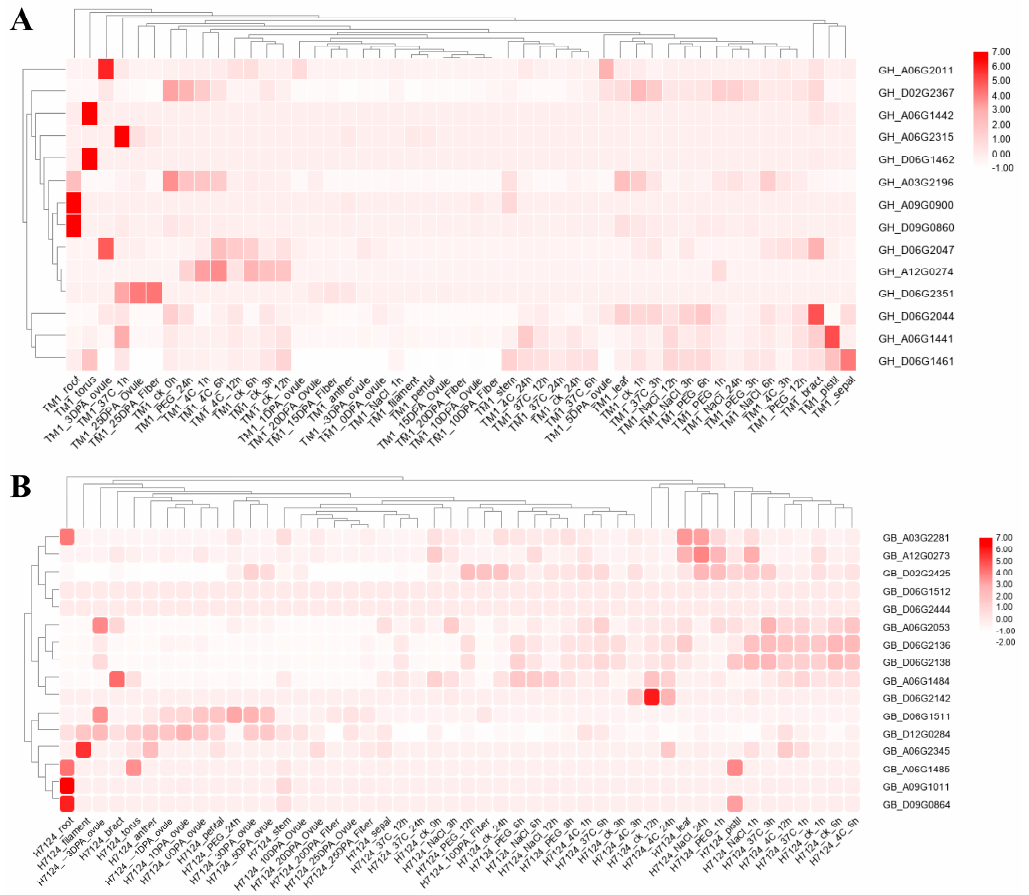
Figure 5. Expression heatmap of PPO genes of the tetraploid cotton species in different organs at the diverse stages of development or under various stress treatments. Note: ( A ) represents the expression situation of PPO genes of G. hirsutum in different organs at the diverse stages of development or under various stress treatments, and ( B ) represents the expression situation of PPO genes of G. barbadense in different organs at the diverse stages of development or under various stress treatments.